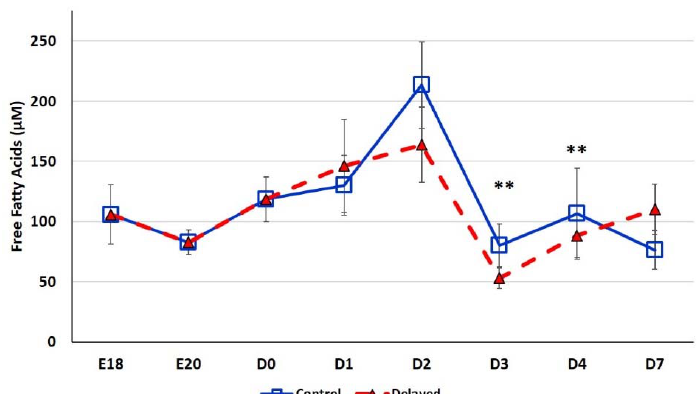
Figure 4. Plasma free fatty acid levels ( µ M) of fed from hatch and delayed fed broiler chicks. Mean (n = 6 males/treatment) plasma free fatty acid levels. Free fatty acids were measured using a free fatty acid fluorometric assay kit (Cayman Chemical). Error bars denote standard deviations. Significant ( p < 0.05) differences between treatment groups were determined using analysis of variance. ** p < 0.001 denotes a significant difference between fed at hatch chicks and chicks delayed access to feed for 48 h.